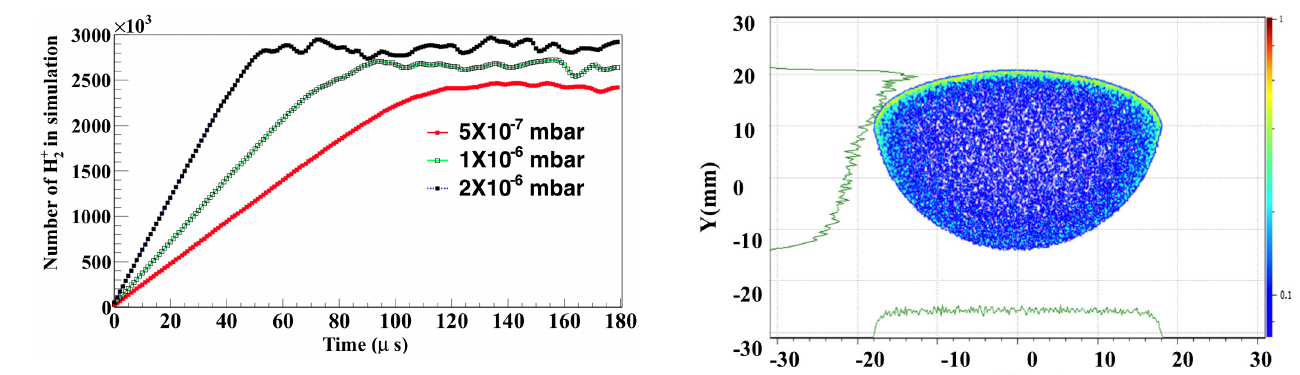
FIG. 11. A number of macro secondary ions captured in the system for different gas pressures.